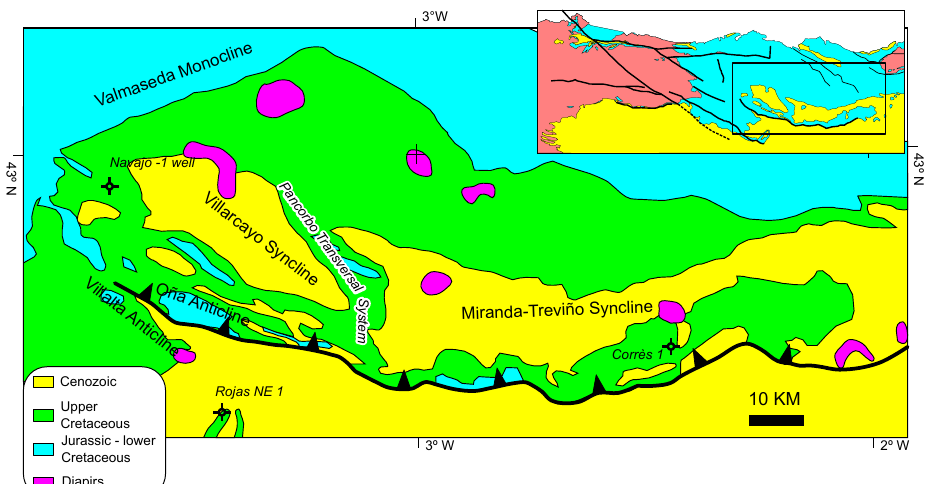
Fig. 11. Geological map of the southern portion of the Basque Pyrenees.